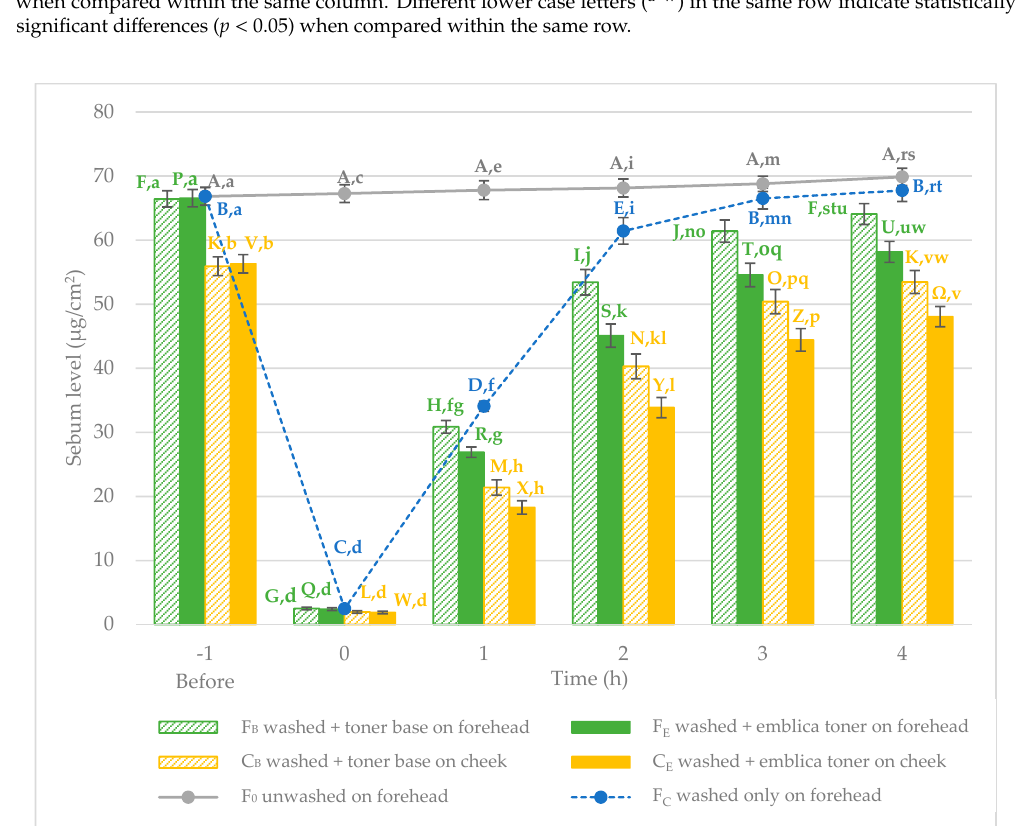
Figure 4. Sebum level on forehead and cheek skins of 30 volunteers at different periods. Different capital letters ( A–Z, Ω ) indicate statistically significant differences ( p < 0.05) in the same treatment among different periods. Different lower case letters ( a–w ) indicate statistically significant differences ( p < 0.05) in the same period among different treatments.